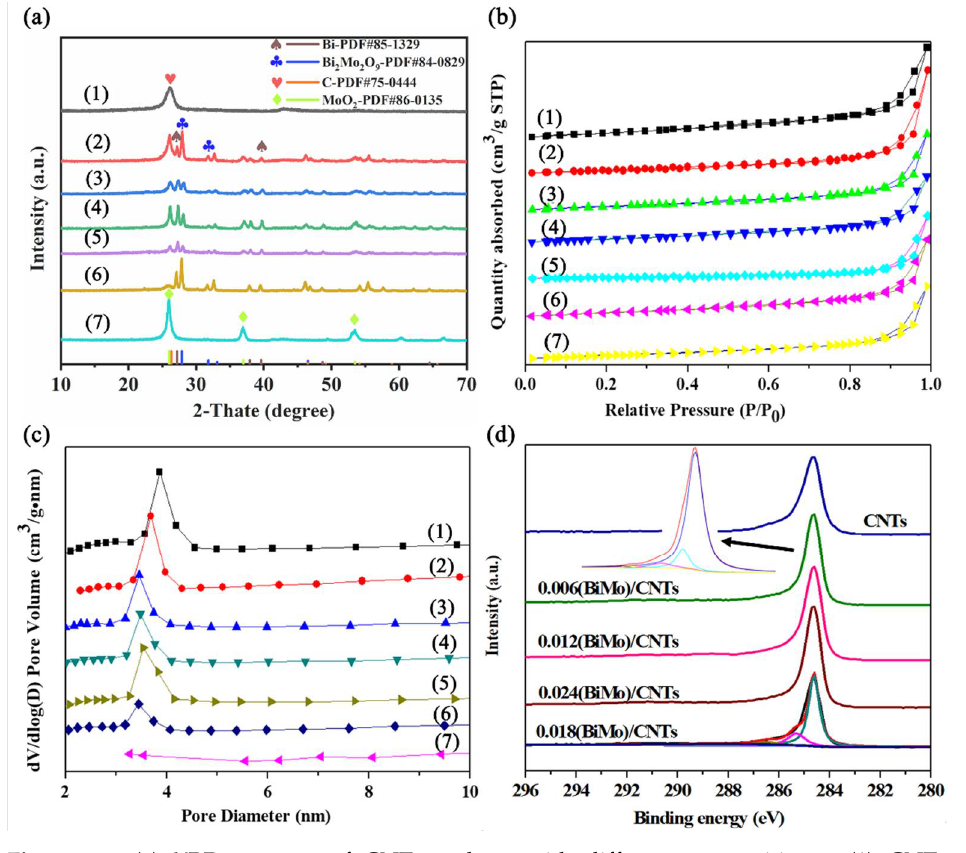
Figure 2. ( a ) XRD patterns of CNT catalysts with different compositions: (1) CNTs, (2) 0.006(BiMo)/CNTs, (3) 0.012(BiMo)/CNTs, (4) 0.018(BiMo)/CNTs, (5) 0.024(BiMo)/CNTs, (6) 0.024Bi/CNTs, and (7) 0.024Mo/CNTs; ( b ) N 2 adsorption–desorption isotherms of CNT catalysts with different compositions; ( c ) their pore size distributions: (1) CNTs, (2) 0.006(BiMo)/CNTs, (3) 0.012(BiMo)/CNTs, (4) 0.018(BiMo)/CNTs, (5) 0.024(BiMo)/CNTs, (6) 0.024Bi/CNTs, and (7) 0.024Mo/CNTs; ( d ) XPS C1s of different catalyst samples. Table 1. BET surface area, total pore volume, and catalytic performance of CNT catalysts with dif- ferent compositions in the absence of steam.